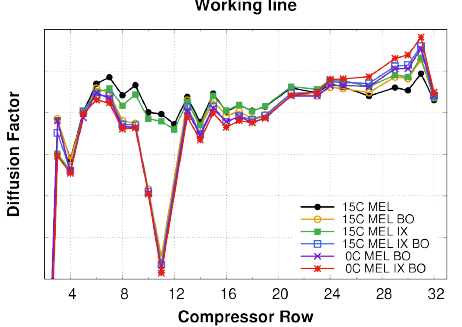
Figure 11. Test matrix diffusion factor for the working line condition for the six configurations